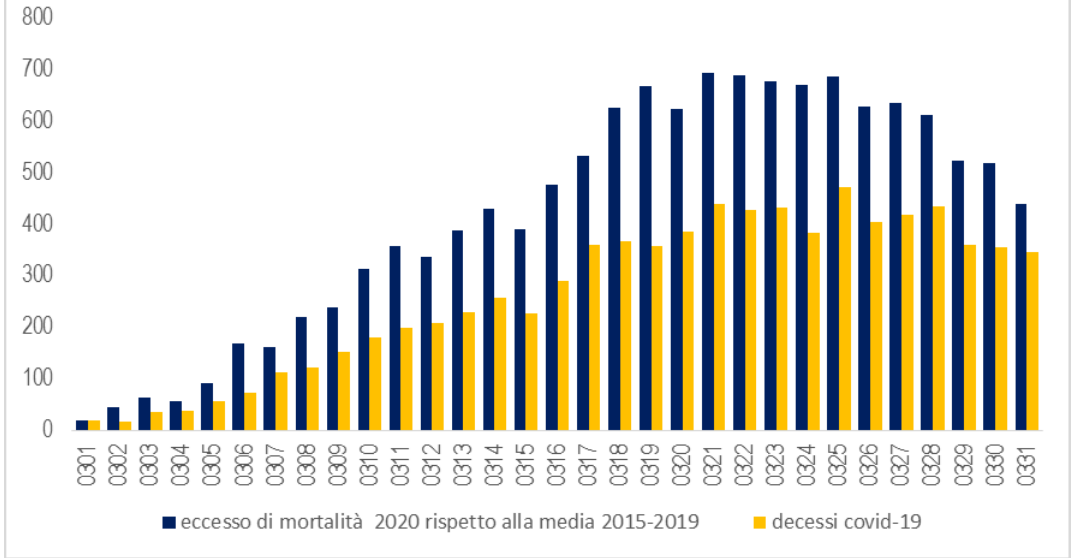
Figura 6. Andamento giornaliero nel mese di marzo dell'eccesso di mortalità maschile registrato nel 2020 rispetto alla media degli anni 2015-2019 e dei decessi Covid-19 (a) . Valori assoluti dei decessi. Province con alta diffusione Covid-19.